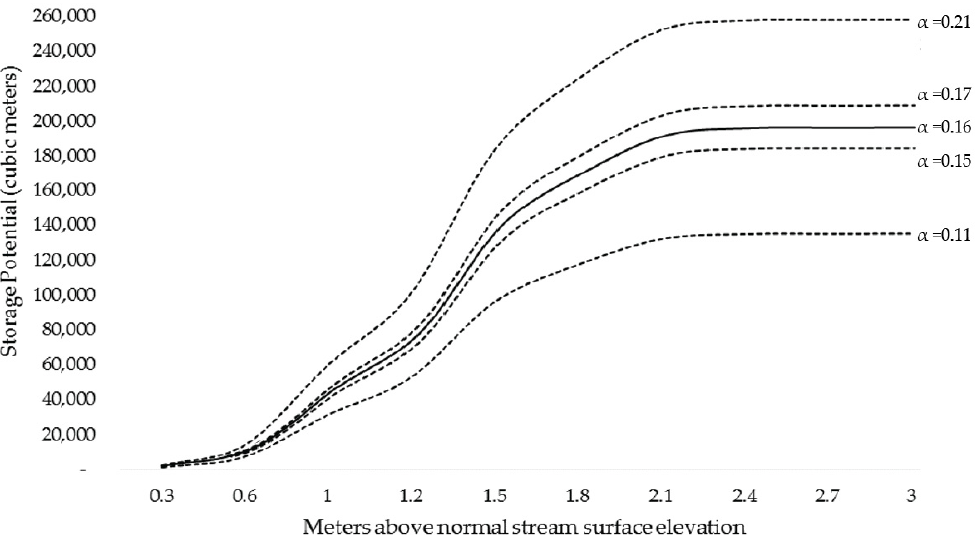
Figure 7. Influence of estimates of porosity ( α ) on water storage potential for the study site. Storage potentials increase as soil porosities increase. Altering porosity by values of ±1% (e.g., 0.16 to 0.17 or 0.15) results in a 6% change in estimates of storage potential. Altering porosity by values of ±5% (e.g., 0.16 to 0.21 or 0.11) results in a 30% change in estimates of storage potential. Below curves are made assuming mid groundwater elevation values ( φ m ).